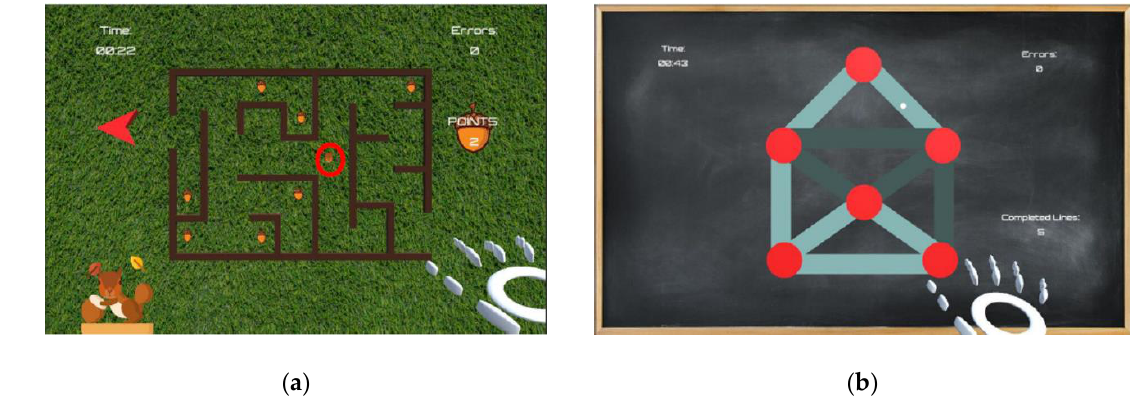
Figure 4. ( a ) “Maze” game and ( b ) “Path” game.